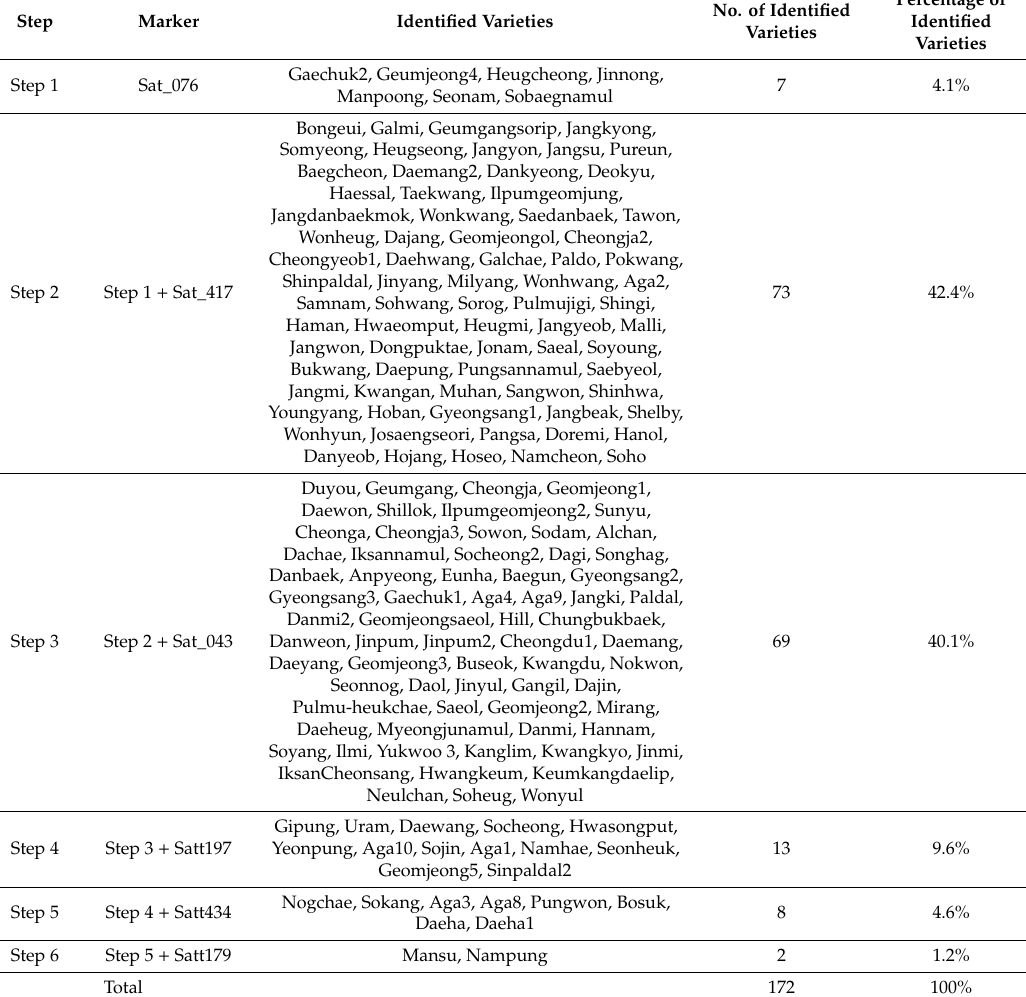
Table 8. Each step of discrimination of 172 Korean soybean varieties using six SSR